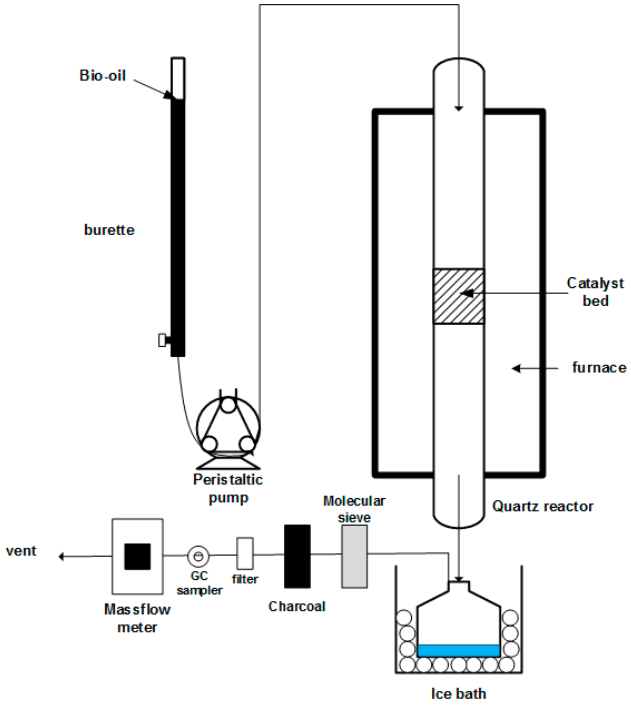
Figure 17. Experimental set-up.